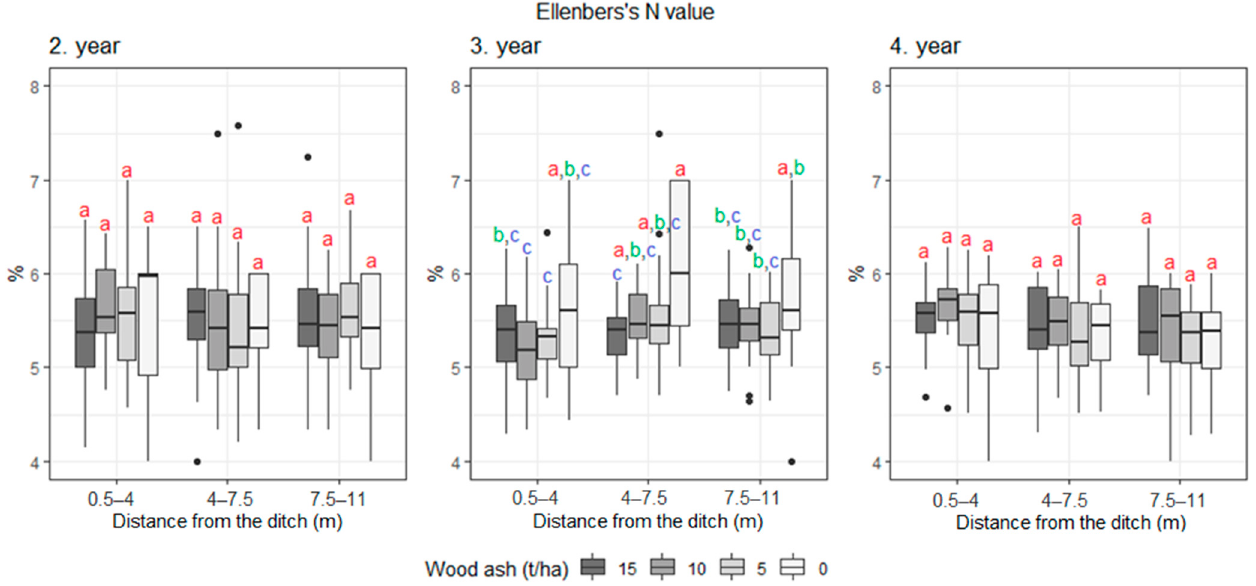
Figure A10. Community weighted mean Ellenberg’s indicator Moisture value depending on the distance from the drainage ditch and the dose of wood-ash fertiliser. Different letters (a, b, c) indicate significant differences between groups, p < 0.05 according to the Tukey HSD test.